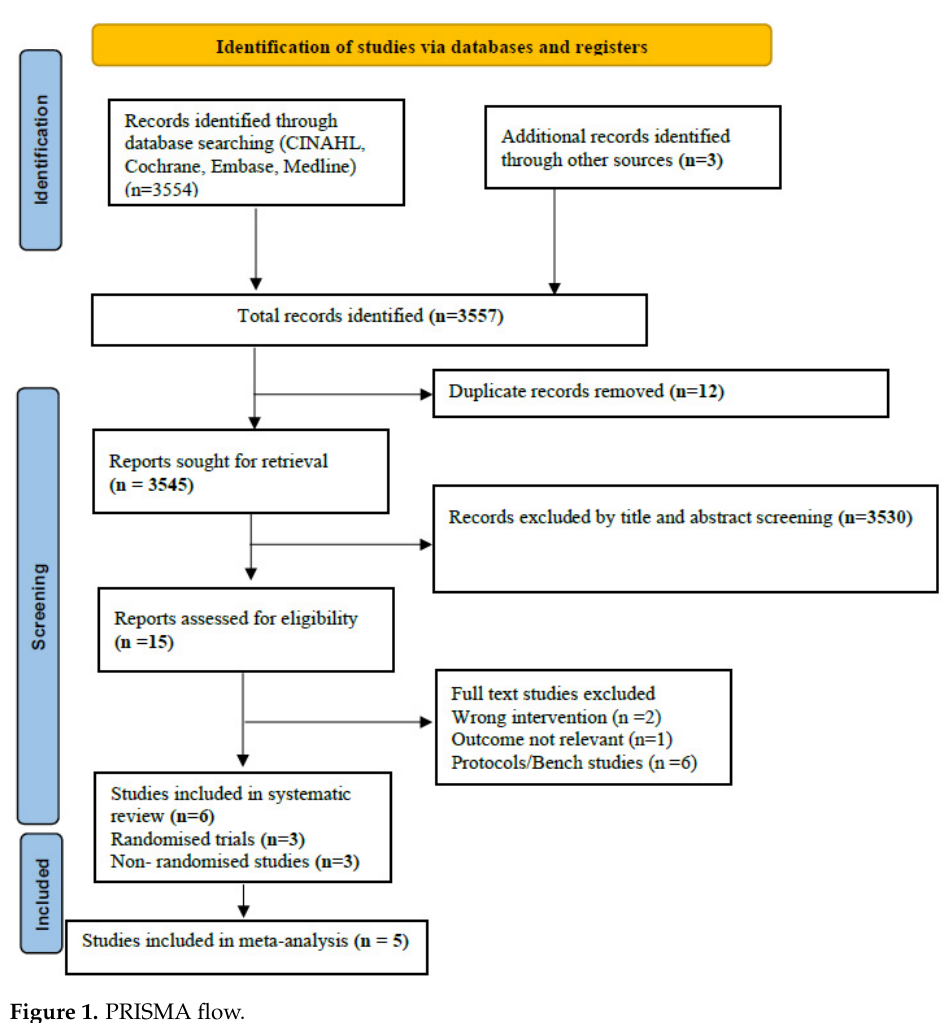
Figure 1. PRISMA Figure 1. PRISMA flow. Table 1. Characteristics of the included studies.